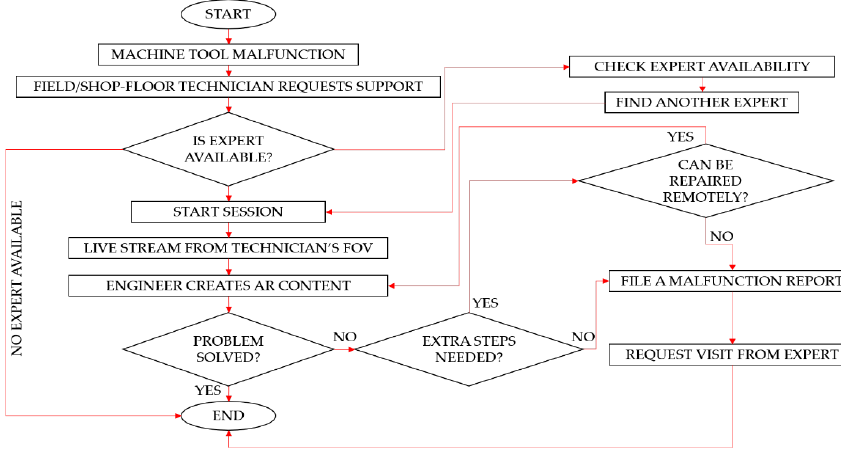
Figure 1. Flowchart of the proposed system.